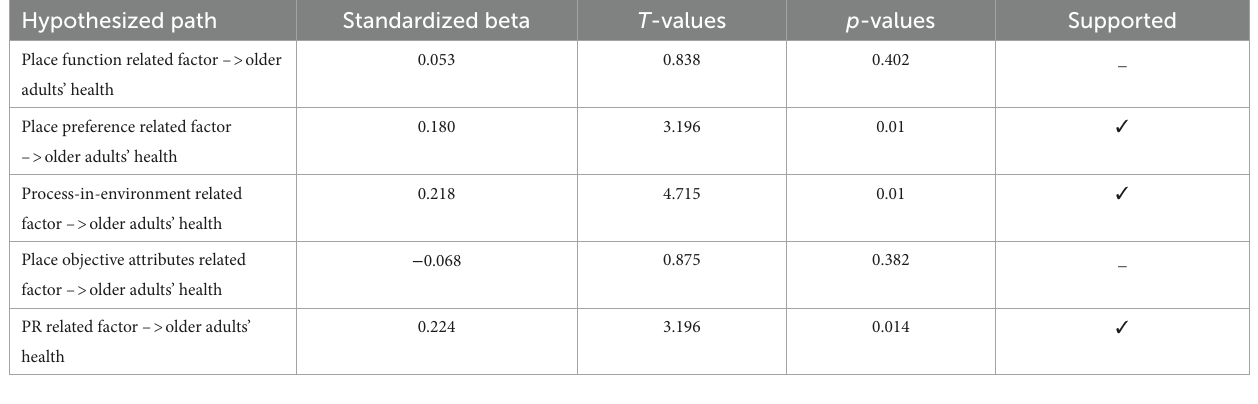
TABLE 4 Path coefficient and T-statistics.